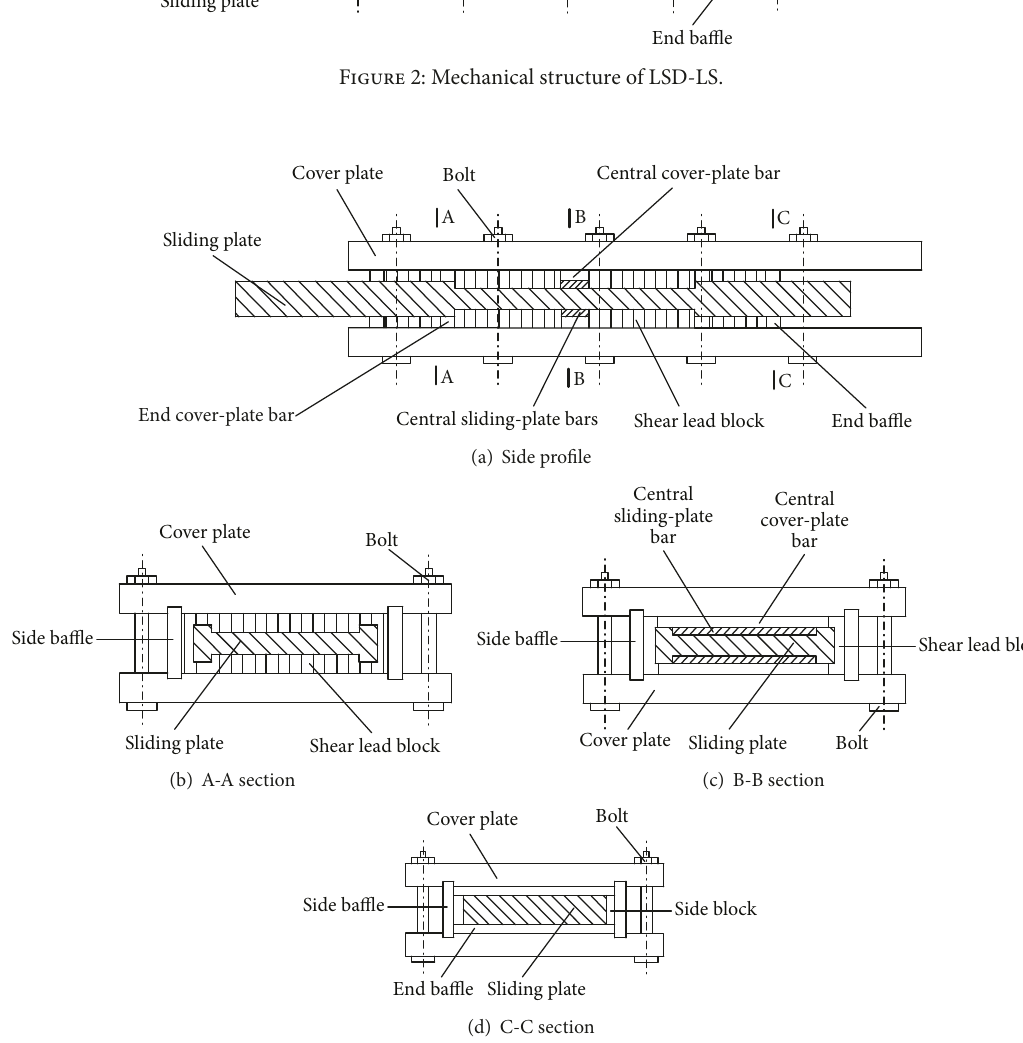
Figure 3: Mechanical structure of